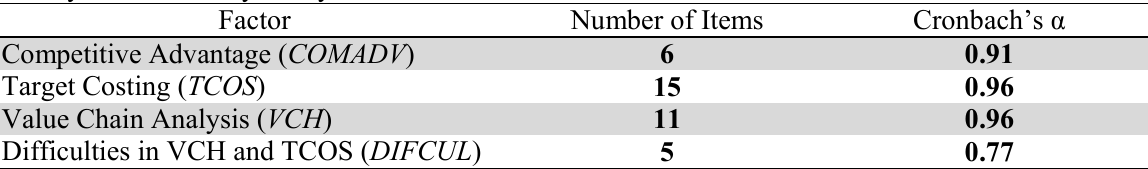
Validity and Reliability Analysis